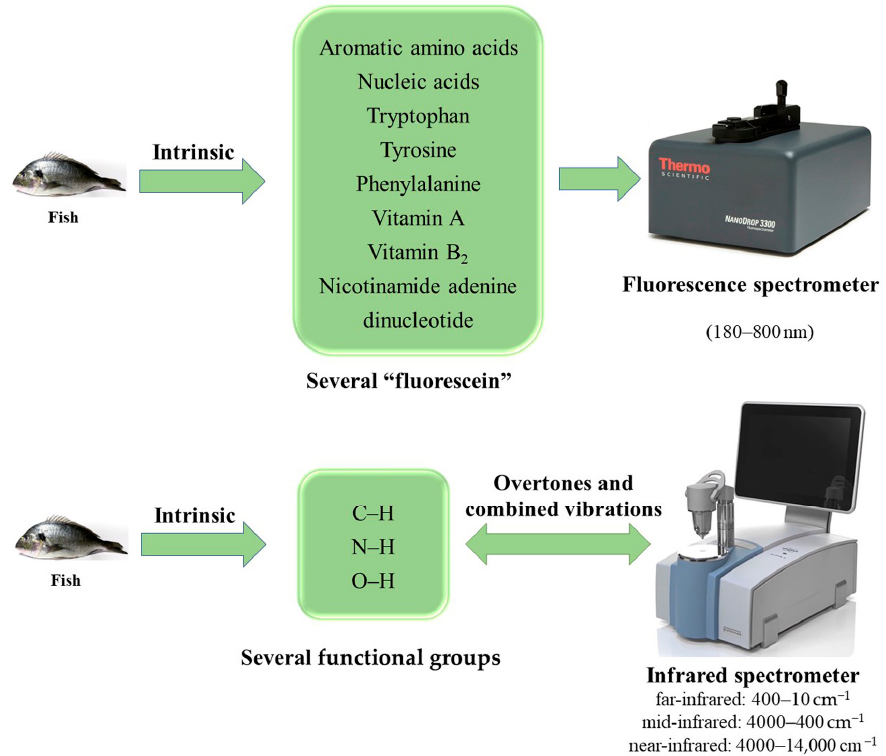
Figure 3. Characterization of fish intrinsic substances and spectroscopic instruments.